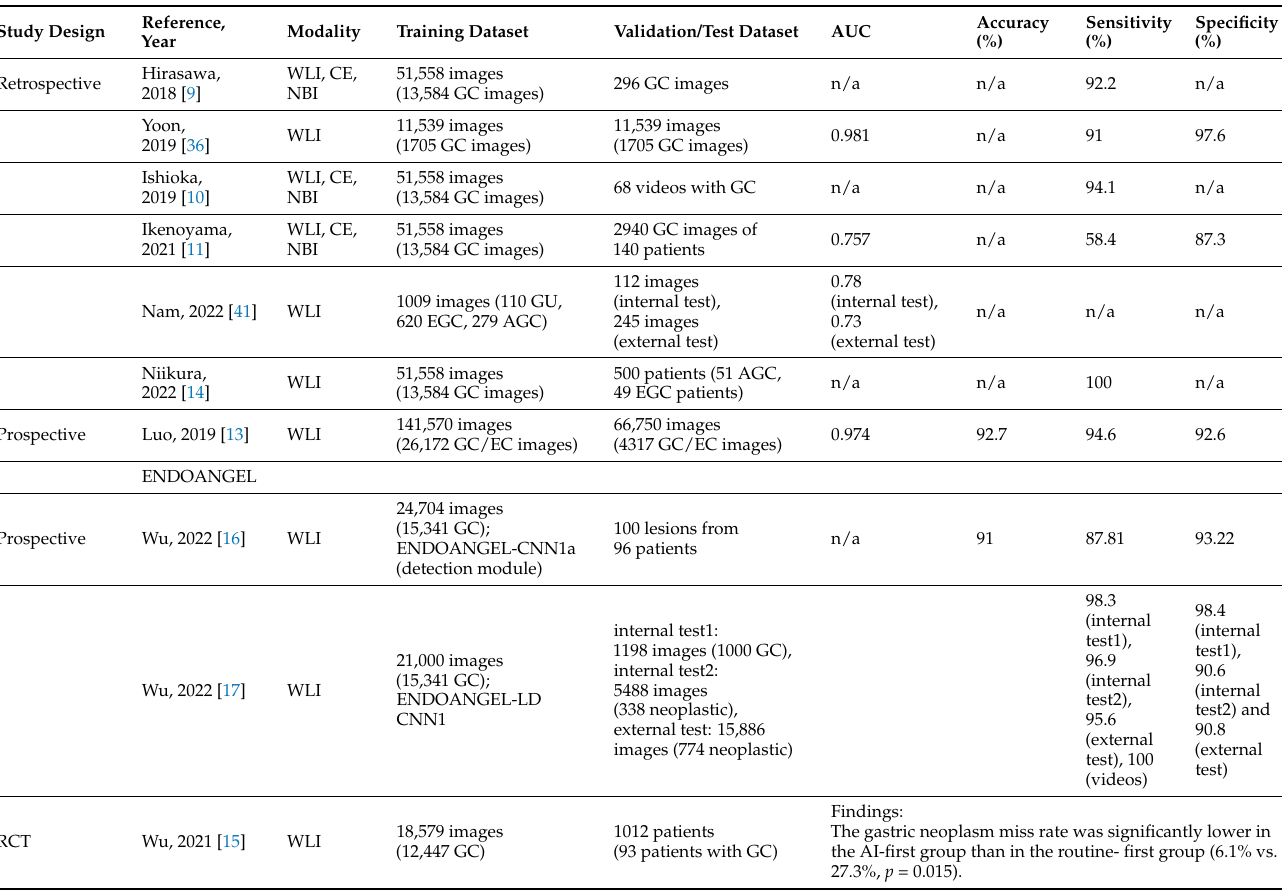
Table 1. Summary of CADe for gastric cancer.